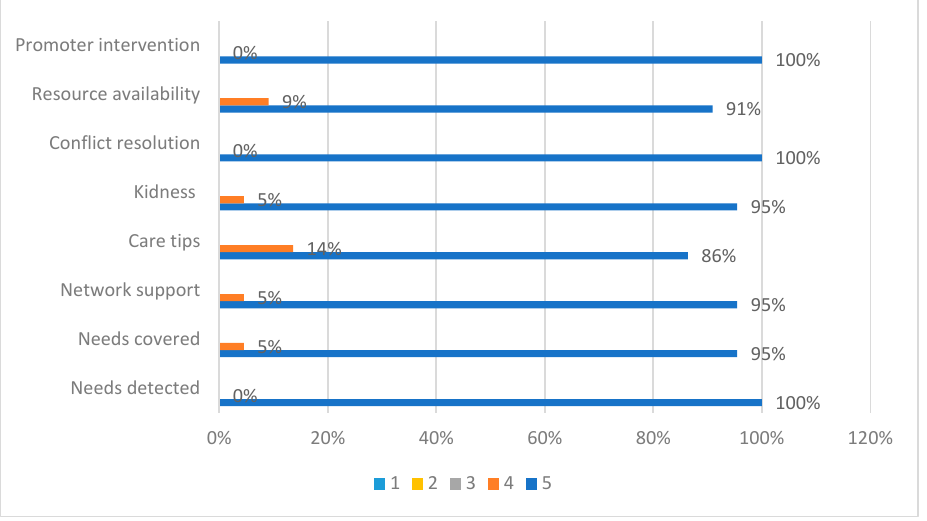
Figure 2. Satisfaction survey of relatives of patients cared for in the “Sevilla Contigo” program.